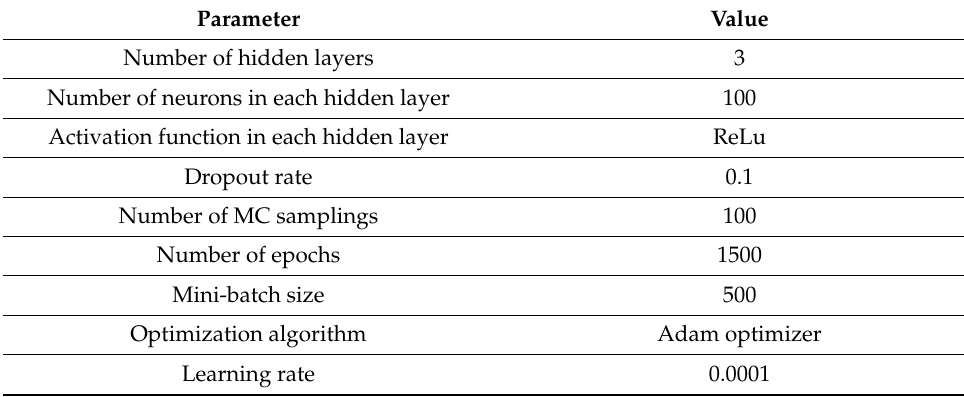
Table 2. Parameter settings of the BNN in the hybrid